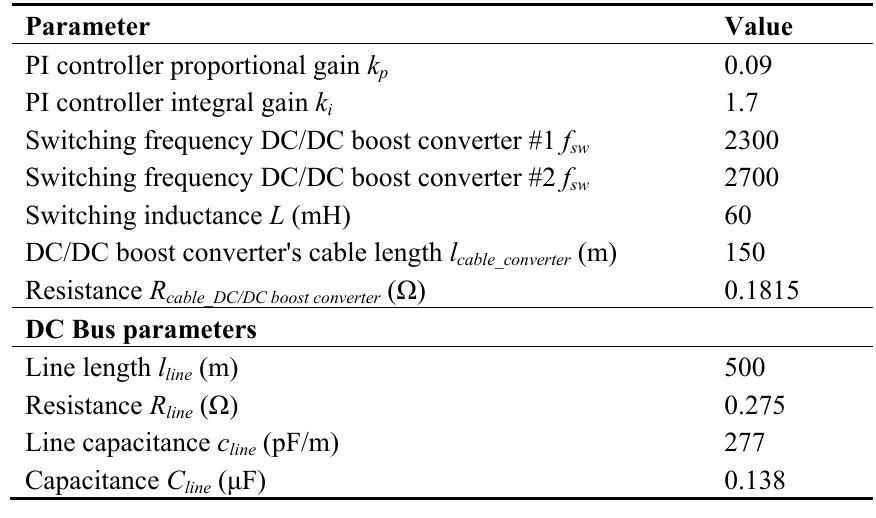
Table 5. Main parameters for each DC/DC boost converter and for the DC